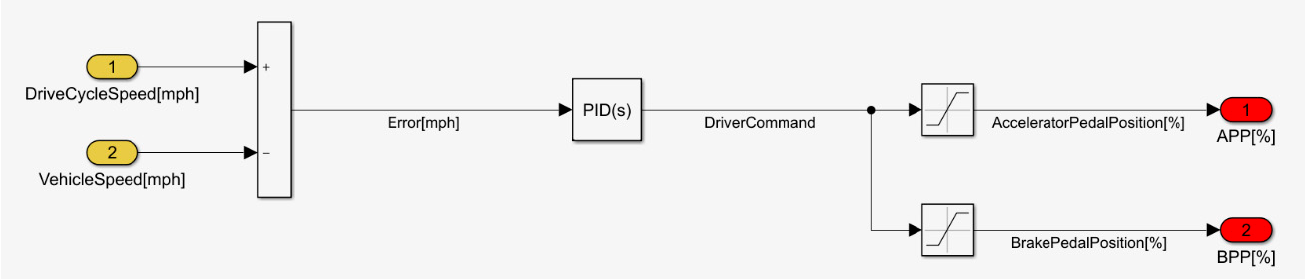
Figure 7. Energy and power analysis of the glider model subsystem Adapted from [16], MathWorks: 2020.